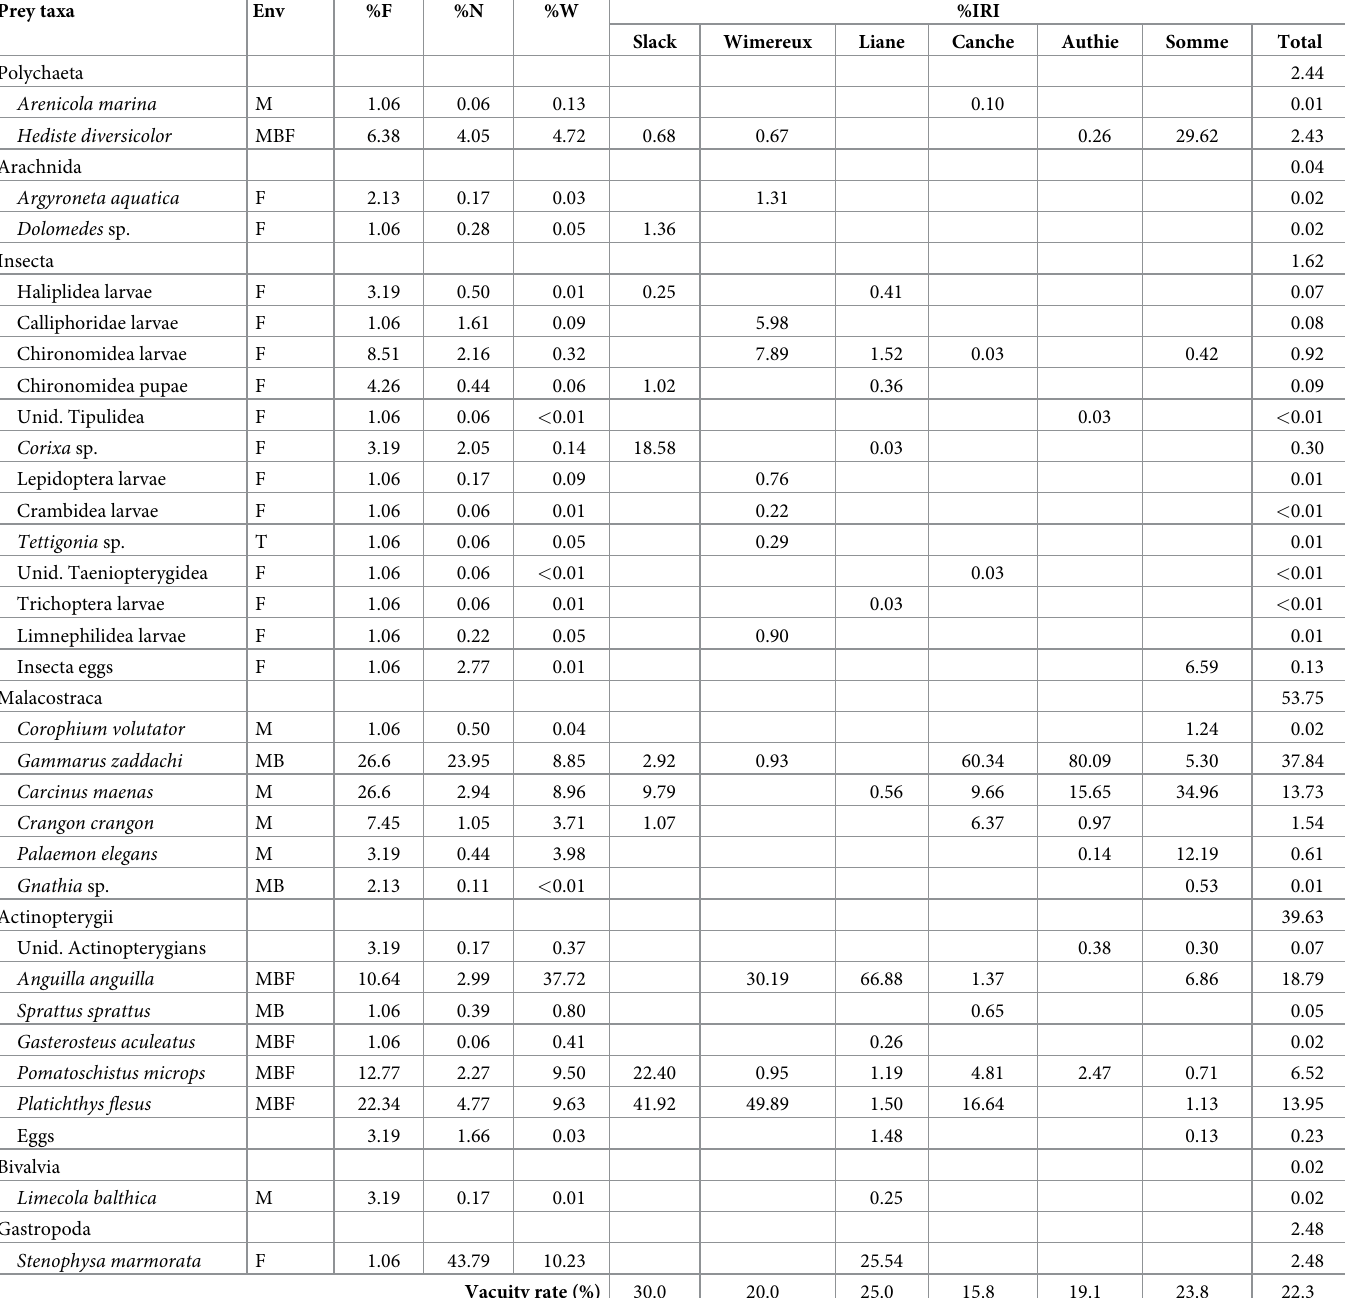
Table 2. Prey composition observed in the gut contents of European eels collected in the six estuaries. Percentage values of prey occurrence (%F), abundance (%N), weight (%W), index of relative importance (%IRI) and empty guts (%) are indicated. Prey taxa Env %F %N %W Slack Wimereux Liane Canche Authie